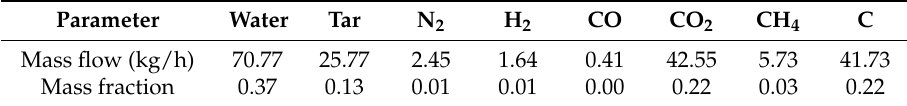
Table 3. Biomass composition out from the tar separation